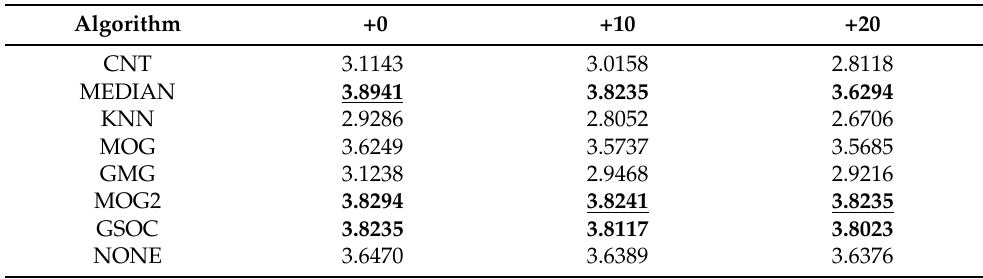
Table 2. Mean values for the noise 0–80 range. The three best results are marked, and the highest value is underlined.